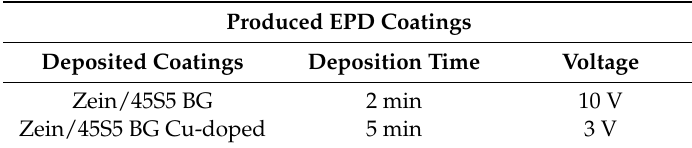
Table 1. Produced coatings showing optimized EPD conditions. BG = bioactive